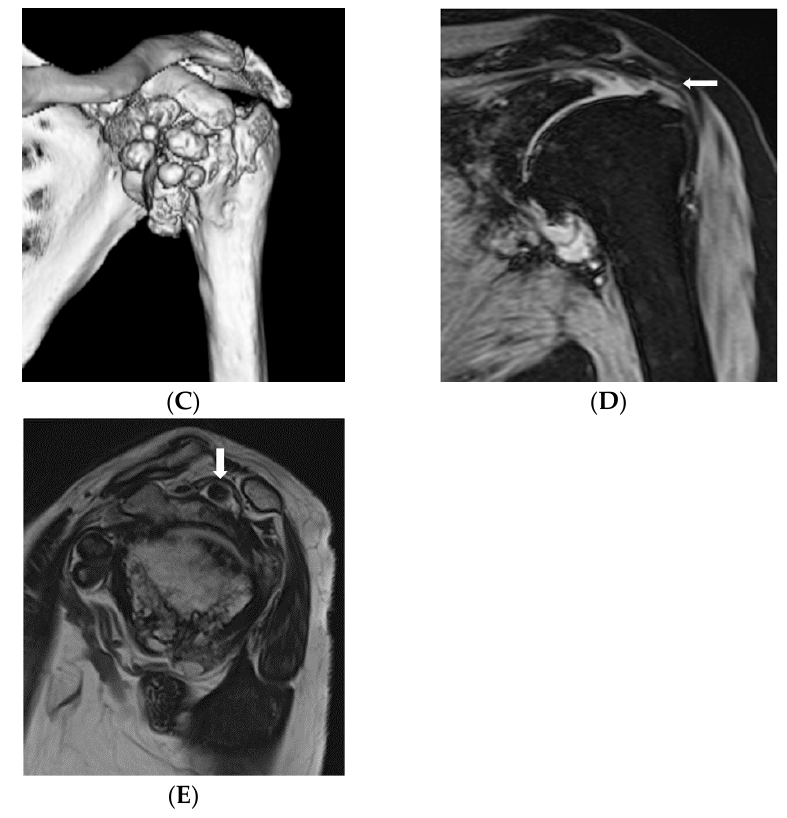
Figure 1. Preoperative evaluation. ( A , B ) On plain radiographs and computed tomography (CT), multiple well-demarcated, ossified masses were observed; ( C ) on three dimensional CT, nodular calcified lesions were similarly present; ( D ) magnetic resonance imaging (MRI) showed a massive tear of the supraspinatus tendon; ( E ) on T2-enhanced images, a hypointense mass-like lesion was found. There were many masses in the shoulder subacromium and humeral head space.